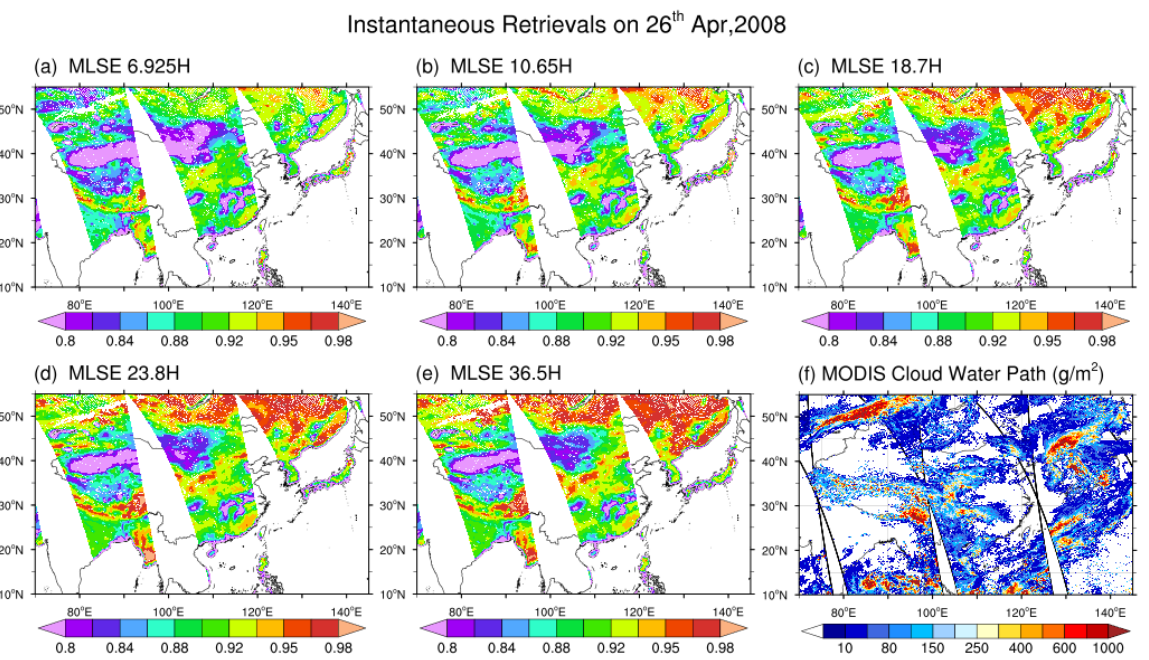
Figure 6. Instantaneous multi-channel MLSE (horizontal polarization) retrieval on 26 April 2008, and the simultaneous MODIS cloud water path (CWP) retrieval in the studying area. ( a ) MLSE, ( b ) MLSE, ( c ) MLSE, ( d ) MLSE, ( e ) MLSE, ( f ) MODIS